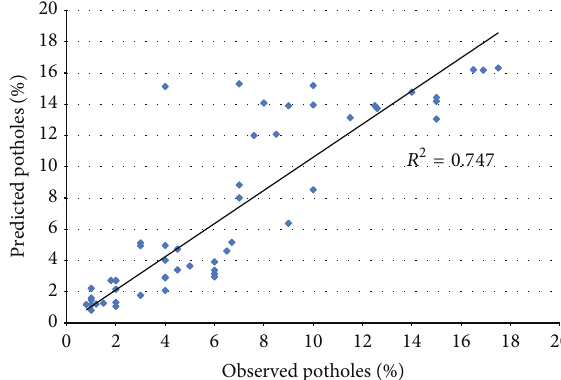
Figure 3: Comparison between predicted and observed pothole values based on the out of sample